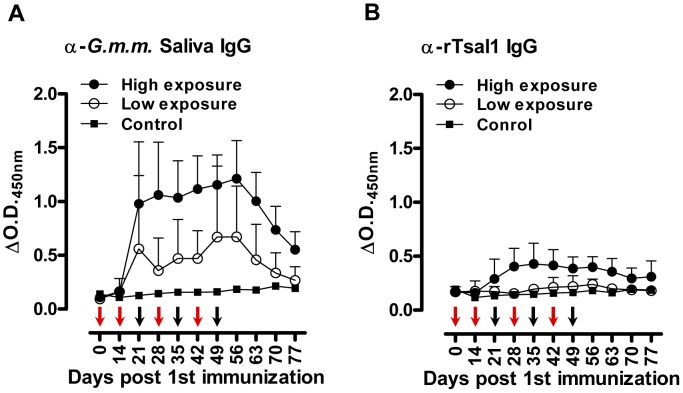
Tsetse fly induced humoral responses in pigs.Follow-up of the anti-G. m. morsitans saliva IgG responses (A) and the anti-rTsal1 IgG responses (B) in pigs exposed to 2 different tsetse fly biting intensities (two-weekly exposure for 6 weeks to 3 flies (low exposure group, n = 4) or weekly exposure for 7 weeks to 30 flies (high exposure group, n = 5)). One non-exposed animal was included as a negative control. Arrows indicate the tsetse exposure regimen for the low exposure (red arrows) and high exposure group (red and black arrows). Presented data are the mean ΔO.D.450 nm values and the 95% CI obtained with a 1∶1600 dilution of the individual plasmas.